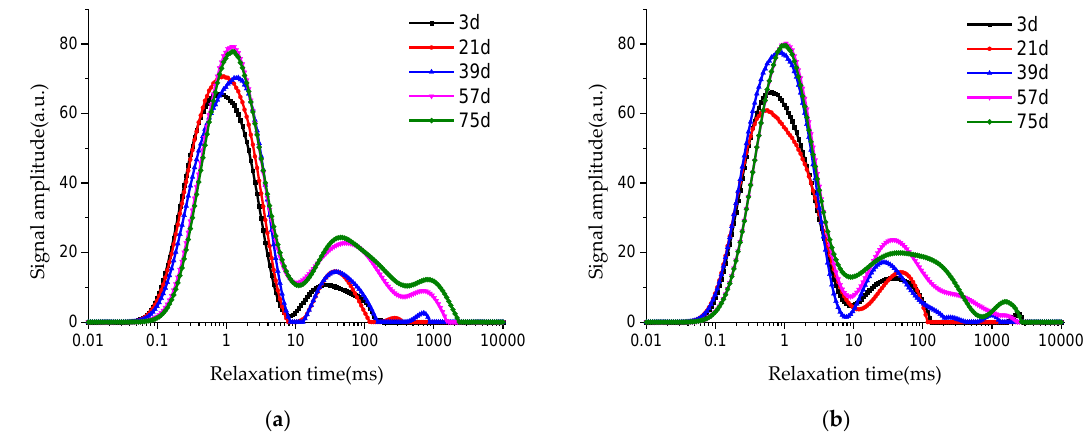
Figure 10. T 2 spectrum distribution of concrete soaked in Na 2 SO 4 solution: ( a ) J5; ( b ) J4.